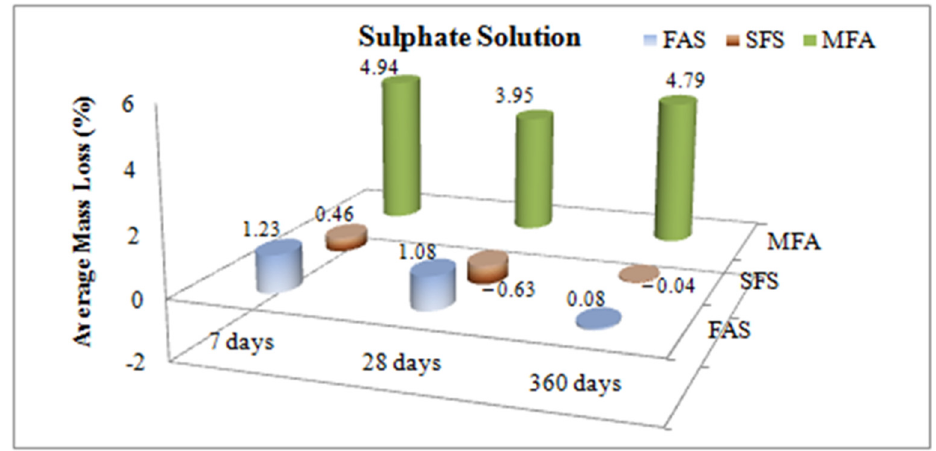
Figure 9. Effects of mineral admixtures on mass loss in sulphate solution.